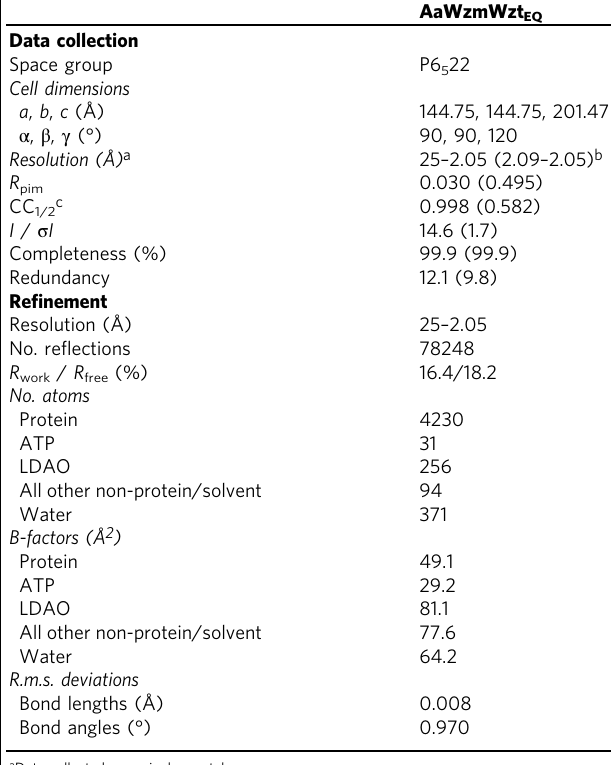
Table 1 Data collection and re fi nement statistics